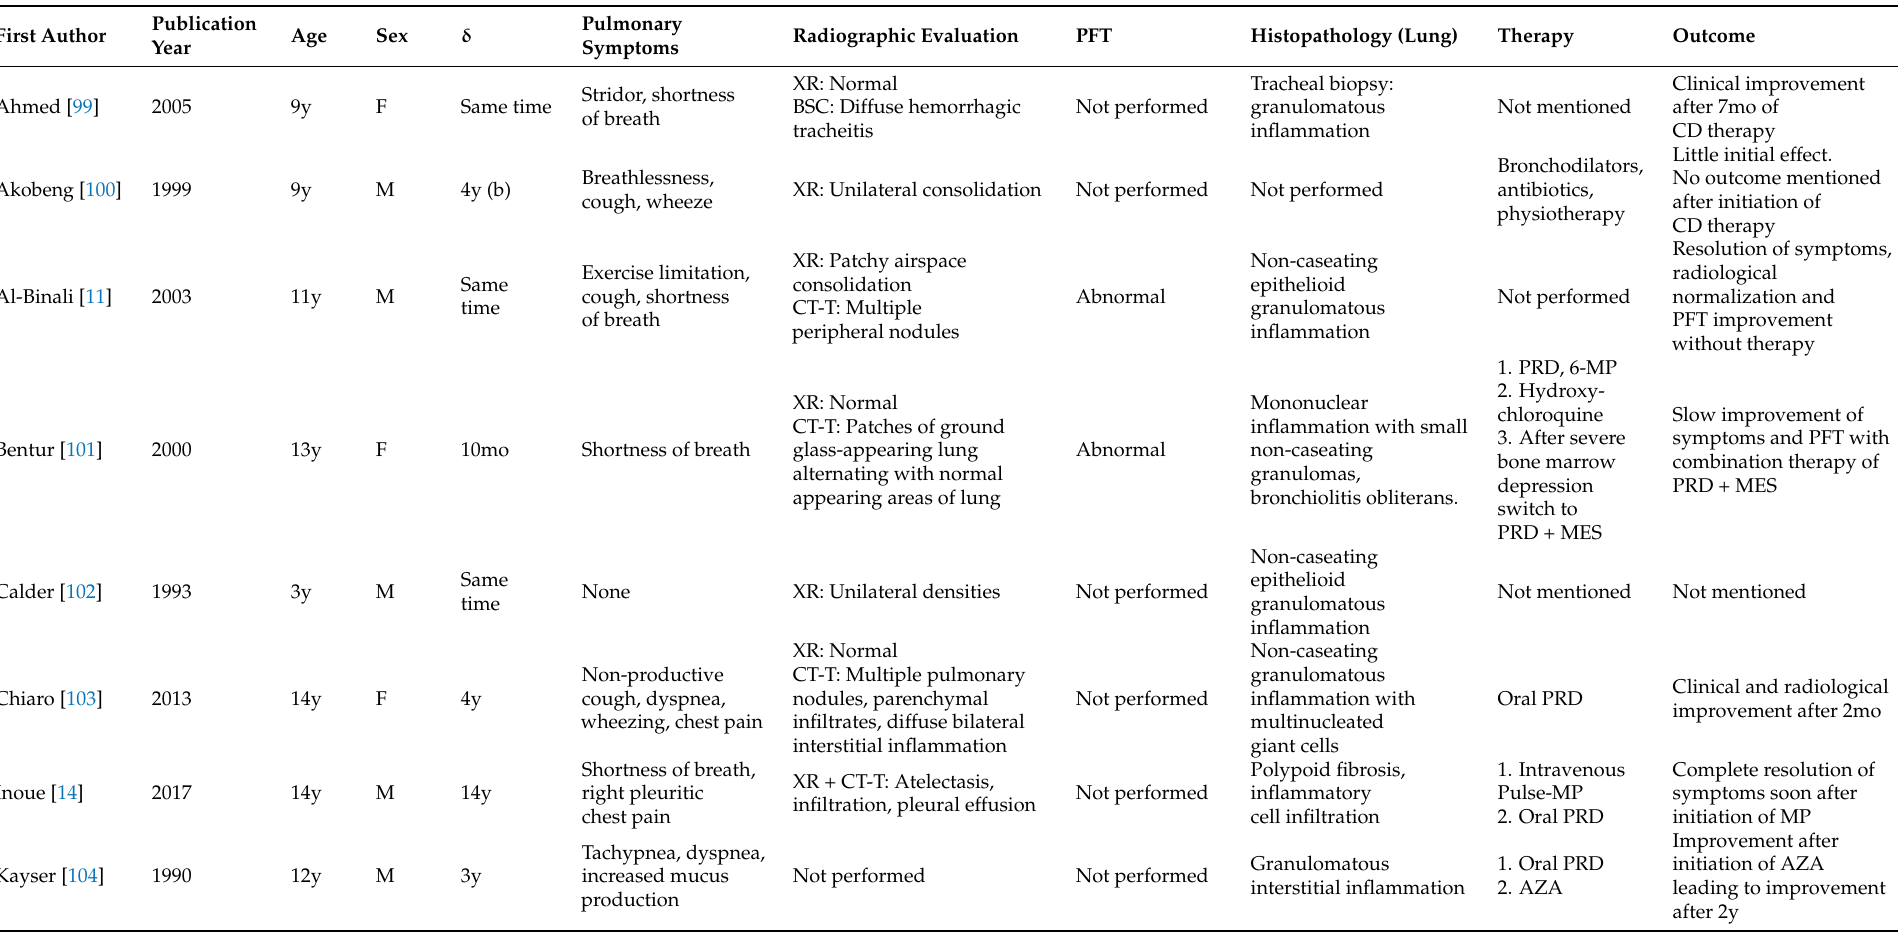
Table 1. Published cases of pulmonary manifestation in pediatric CD